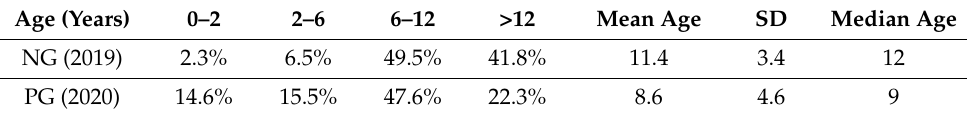
Table 2. Patients divided by age groups admitted to ER: differences between NG and PG. Table 1. Demographic differences between NG and PG.